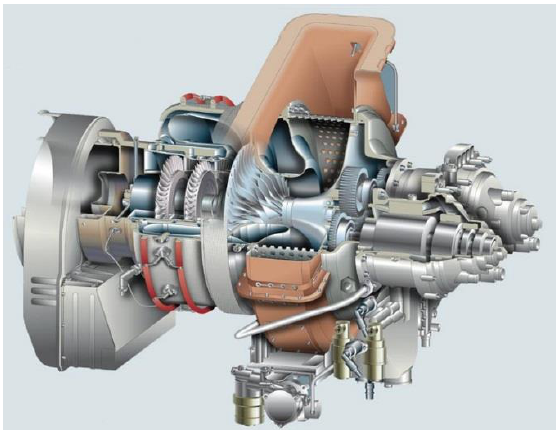
Figure 11. Cross-section of the APS5000 engine [24]. (Reproduced with permission from Pamintuan,